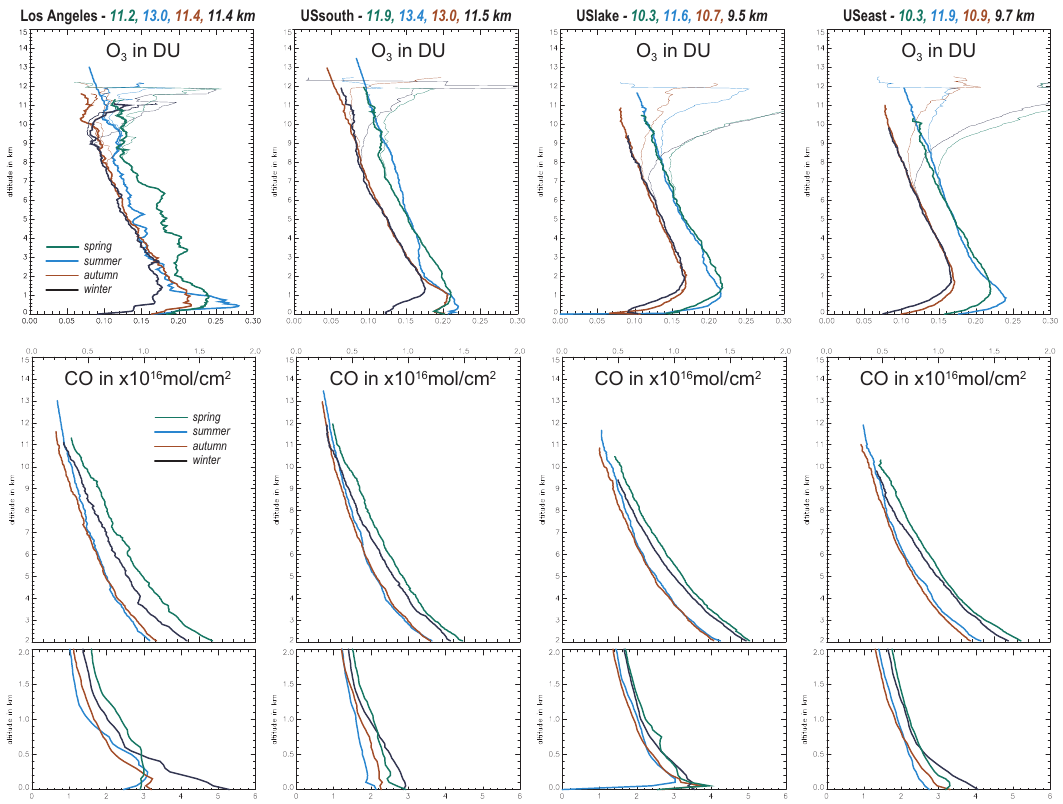
Fig. 8. Seasonal profiles for O 3 and CO (top and bottom) over Los Angeles, USsouth, USlake and USeast (left to right). For O 3 , MP s (O 3 ) are the thin lines and PTP s (O 3 ) are the thick lines limited to the seasonal z DT and expressed in DU. The CO includes only the PTP s (CO), expressed in × 10 16 moleculescm − 2 , using different horizontal scales and two vertical scales for altitude (0–2km bottom, 2–15km top). The spring, summer, autumn and winter profiles are in green, blue, brown and black, respectively. The seasonal z DT are given using the seasonal colours on the top of each site plot in